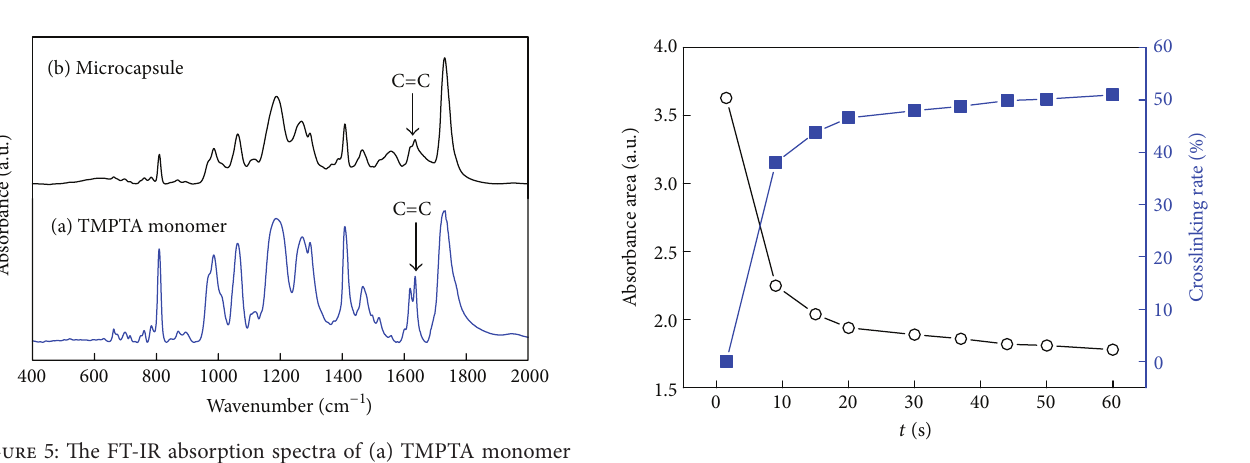
Figure 5: The FT-IR absorption spectra of (a) TMPTA monomer and (b) the microcapsule.